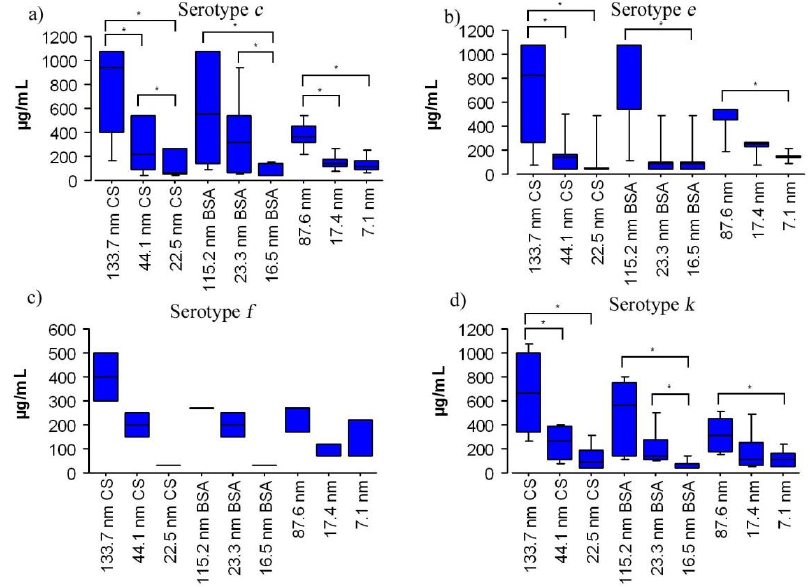
Figure 4. The antimicrobial activity of coated SNP agasint S. mutans serotypes in microgams per milliliter (µg/mL) according to serotypes and particle size. Values shown are the mean ± standard deviation. Clinical strains, 34 in number, ( c = 20; e = 6; f = 1 and k = 7) were assayed. Asteriks indicate significant differences ( p < 0.05).